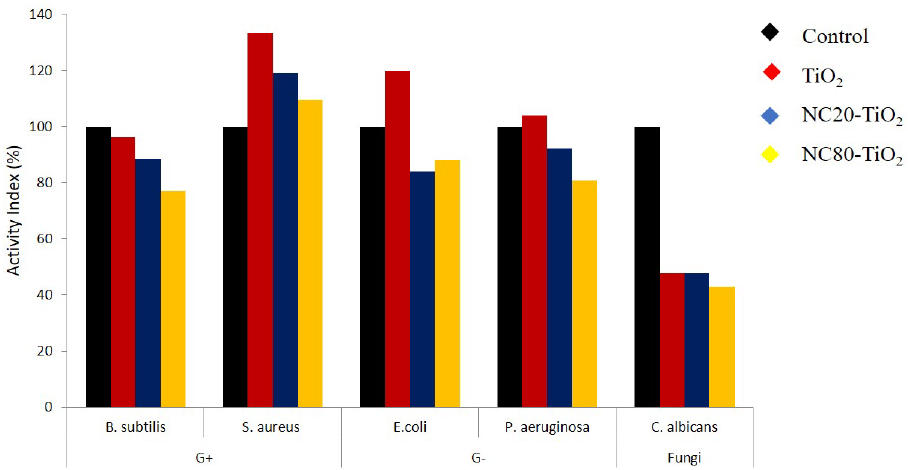
Figure 10. Antimicrobial activities (activity index %) for TiO 2 and NC–TiO 2 nanocomposites. Blank paper is added as